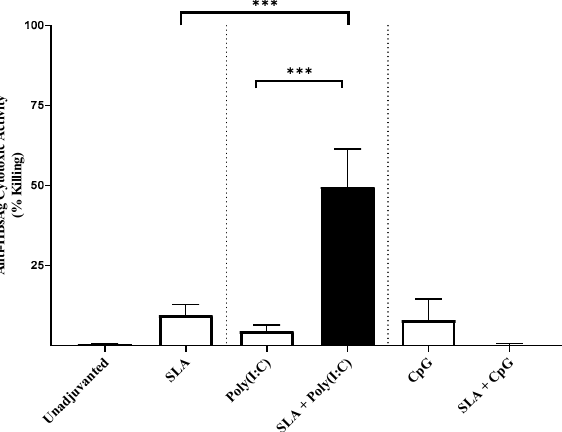
Figure 6. In vivo CTL activity induced by adjuvant combination vaccine formulations. Mice were immunized with vaccine formulations containing HBsAg antigen, alone or formulated with SLA archaeosomes, other adjuvants (Poly(I:C) and CpG) or SLA in combination with other adjuvants. Target cells were formed by pulsing CFSE-labeled splenocytes from naïve mice with CD8 epitopes from HBsAg and then transferred to immunized mice. On the following day (day 28: 7 days post-2nd immunization), splenocytes were collected and the levels of the target cells determined by flow cytometry. Grouped data are presented as mean + SEM ( n = 5/group). *** represents p <